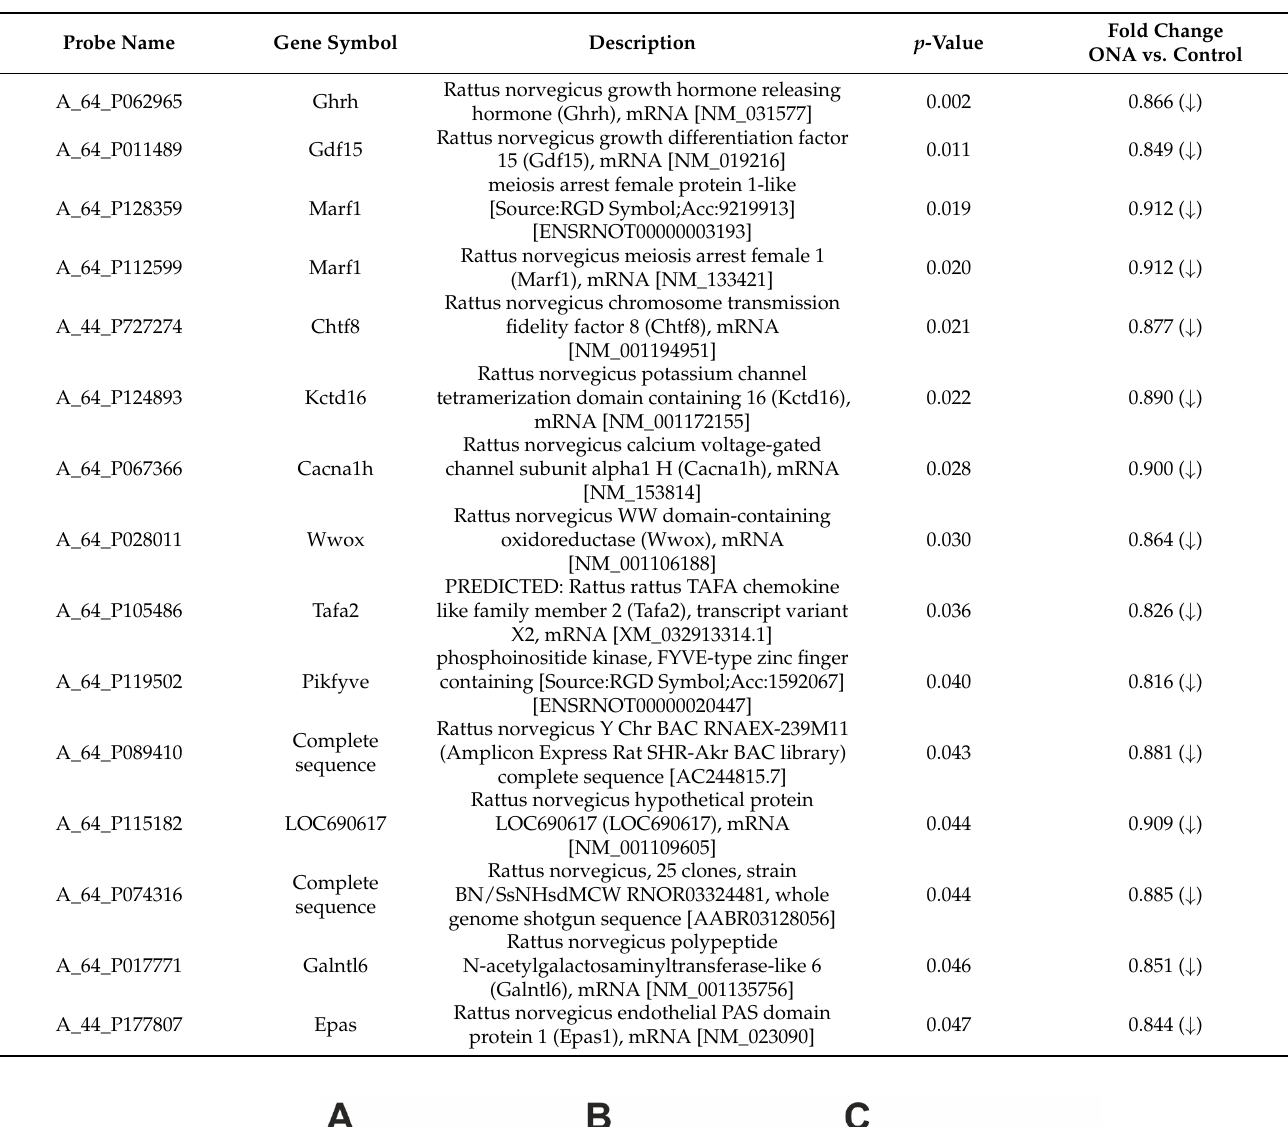
Table 4. Oligonucleotide probes, which were found downregulated in ONA animals.